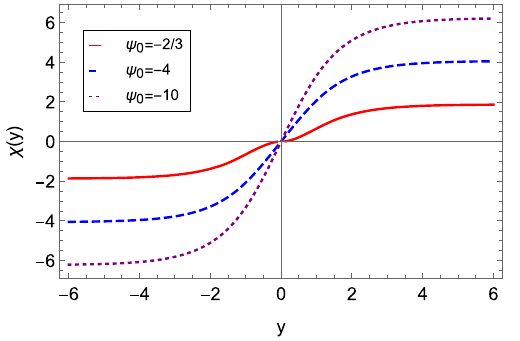
Fig. 4 Numerical solutions for the potential V ( y ) from Sect. 3.3 with ϕ = 10, and ψ = 1. Similarly to the case without matter, the behavior 0 0 of the potential is strongly dependent on the boundary conditions V 0 and ϕ 0